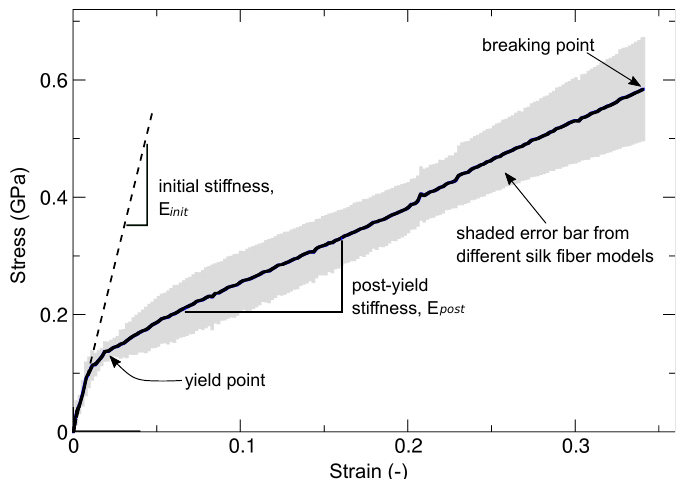
Figure 3. Tensile stress–strain curve for the FE dragline silk models from the spider Araneus diadematus for 0.4 m/s pulling velocity. The black line is the average of the stress–strain curves of the different 3D fiber models (differing in their random arrangement of the crystal units). The gray shaded area indicates the variation. The stress ( σ ) is defined as the resistance force per unit cross-sectional area of the silk fiber model. The strain ( (cid:101) ) is the ratio of change in silk fiber length to its initial length. The fiber model reached the highest point, which is defined as a breaking point, and the associated stress and strain values are the strength ( σ max ) and extensibility ( (cid:101) max ), respectively. The stress–strain curve’s initial slope (the elastic limit) can be used to measure Young’s modulus (E init ). After yield point, the slope of the stress–strain curve is assigned as post-yield stiffness (E post ). The material’s toughness can be defined as the area under the stress–strain curve.